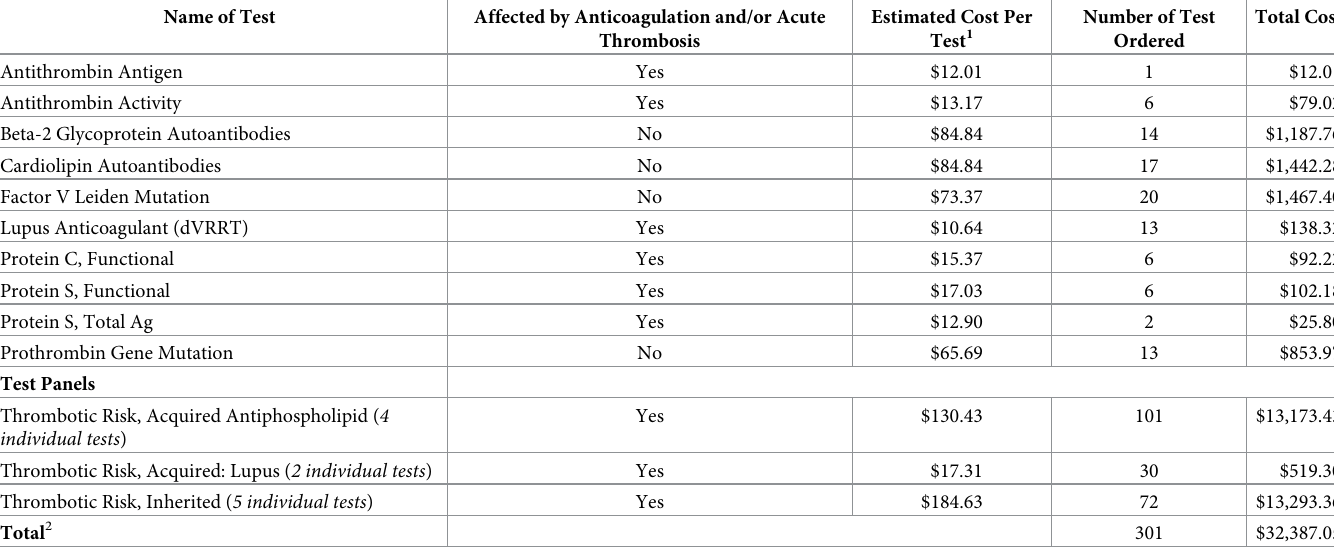
Table 3. Inappropriate thrombophilia tests ordered and